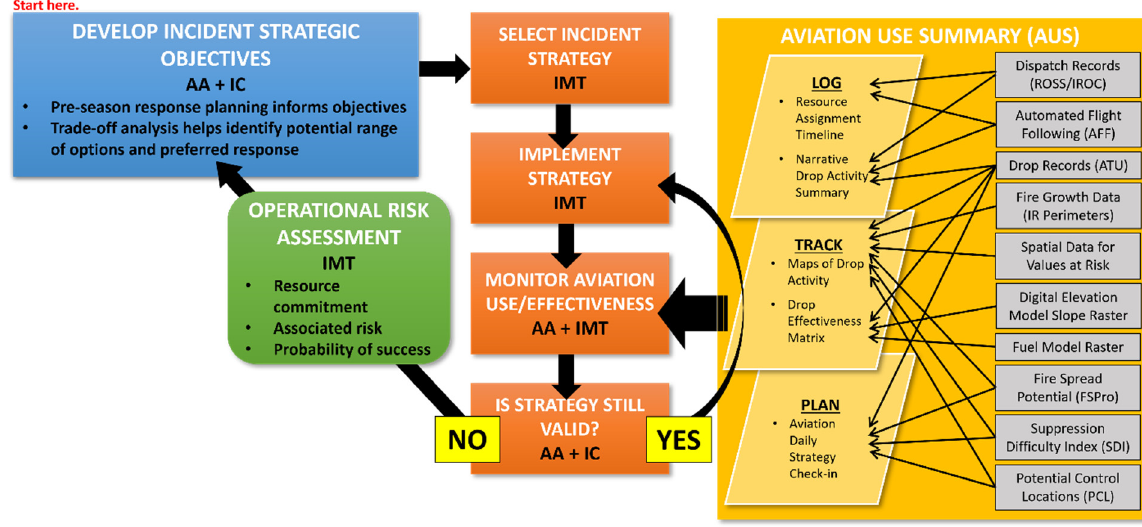
Figure 3. Flowchart depicting a risk-informed decision-making (RIDM) process that uses land management strategic objectives to inform a wildfire’s management strategy. The RIDM then monitors ongoing actions—in this example, aviation use and effectiveness—through development of the Aviation Use Summary (AUS). This information can help managers ensure the validity of a current strategy given changing conditions and fire growth, and an operational risk assessment informs development of alternative strategies. Examples of the AUS components included in this flowchart (e.g., Resource Assignment Timeline) are each presented later in this manuscript. AA—Agency Administrator; IMT—Incident Management Team; IC—Incident Commander; ROSS—Resource Ordering and Status System; IROC—Inter-agency Resource Ordering and Capability; ATU—Additional Telemetry Unit; IR—infrared; FSPro—Fire Spread